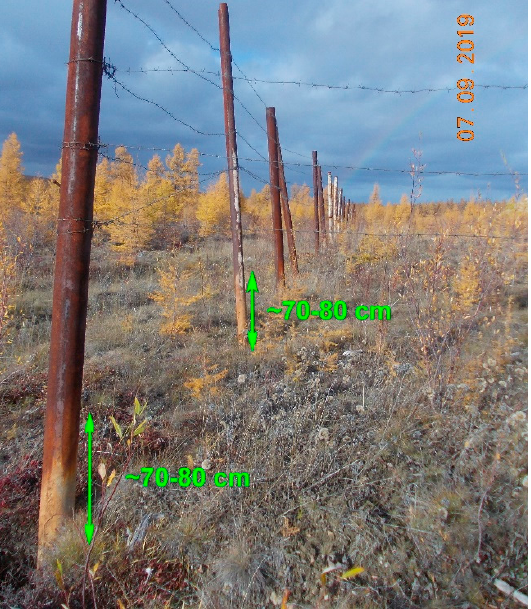
Figure 8. Stakes emerged from the subsided ground (September 2019).